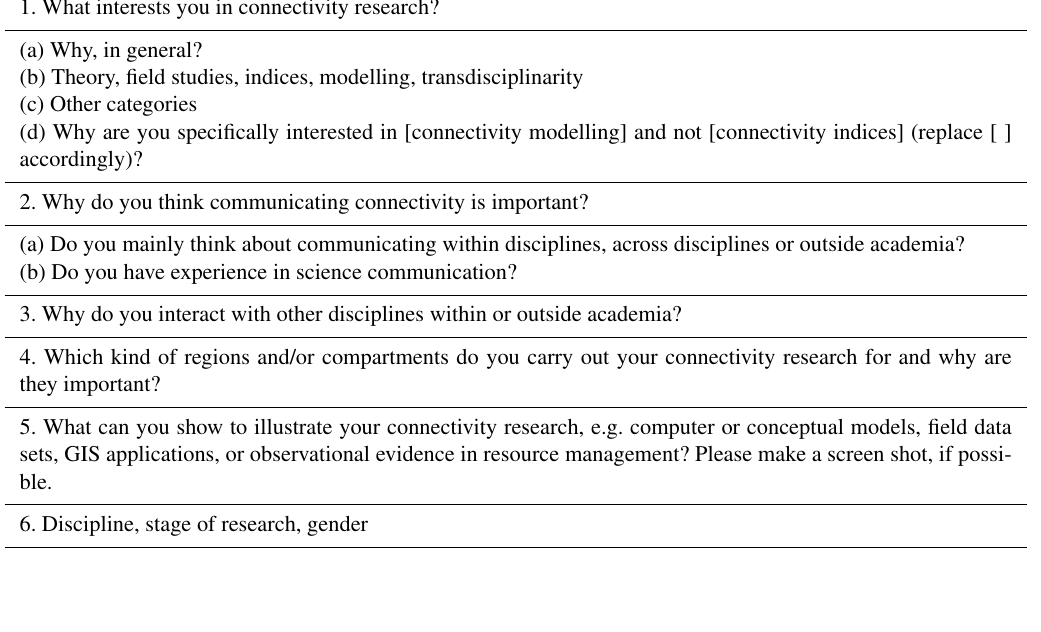
Table 2. Elicited attributes of connectivity